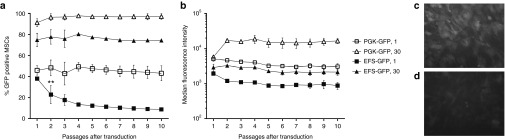
Comparison of the PGK and EFS promoter for sustained GFP expression in mMSCs. (a) The percentage of mMSCs expressing GFP and (b) their median fluorescence intensity following transduction at multiplicity of infection (MOI) 1 (squares) or MOI 30 (triangles) using FVV:PGK-GFP (white) or FVV:EFS-GFP (black). Flow cytometry analysis was performed when cells reached ~90% confluence at 1 to 10 passages post-transduction. For each passage, 1/10th of the total cells were reseeded. Data points show the mean + SD of data from biological triplicates. Asterisks mark values that are significantly different from the previous passage of the same sample, as determined by two-way analysis of variance with Bonferroni multiple comparisons tests. (c,d) Representative photomicrographs of GFP fluorescence in mMSCs transduced at a MOI of 30 with PGK-GFP (c) or EFS-GFP (d), taken three passages post-transduction. FVV, foamy virus vector.